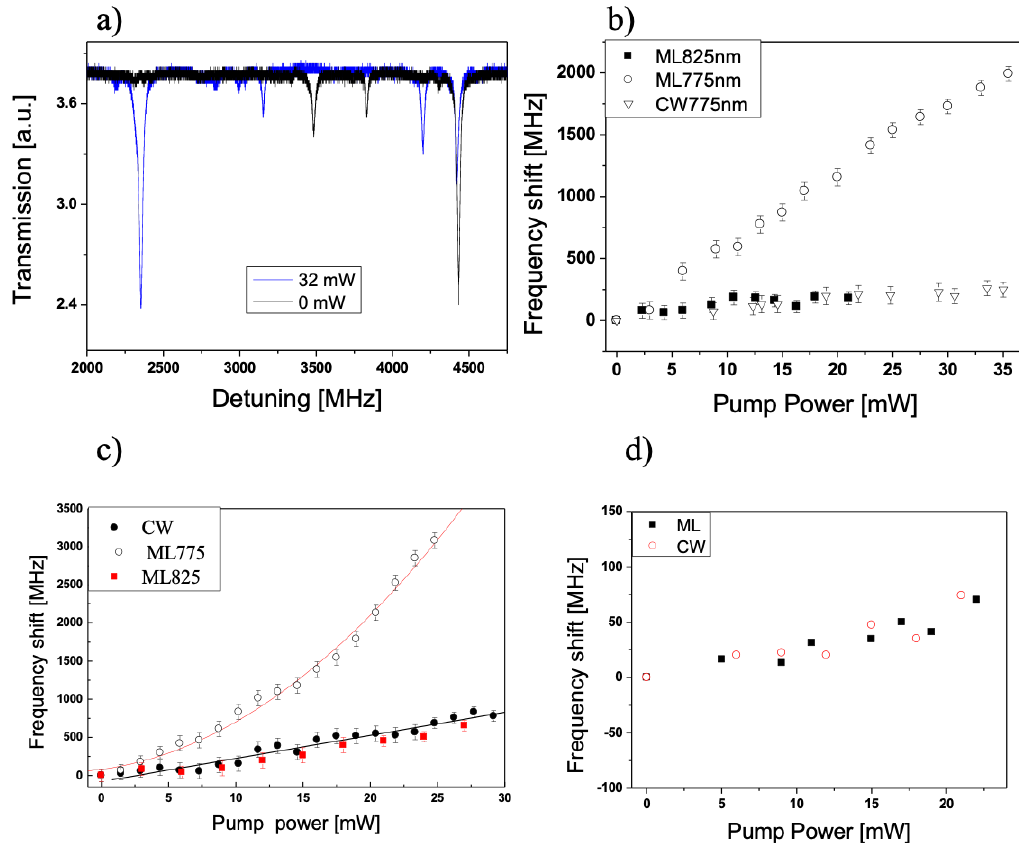
Figure 12. ( a ) Typical WGM spectra measured for a polymer-coated microsphere for two different pump powers: (black) pump laser off and (blue) 32 mW. λ pump = 775 nm, λ probe = 1600 nm. ( b ) Pump power dependence of the detuning of WGM in PF(o)n coated microspheres for mode-locked regime of the Ti-sapphire pump laser: 825 nm (filled squares) and 775 nm (empty circles); and CW at 775 nm (empty downside triangles). ( c ) The probe wavelength is λ probe = 1558 nm, switching for CW (filled circles), mode-locked at 775 nm (empty circles) and mode-locked at 825 nm. ( d ) Eudragit coated microspheres for mode-locked regime of the Ti-sapphire pump laser for two different regimes: CW (empty circles) and pulsed (filled squares). The probe wavelength is λ probe = 1558 nm. Reproduced with modifications from